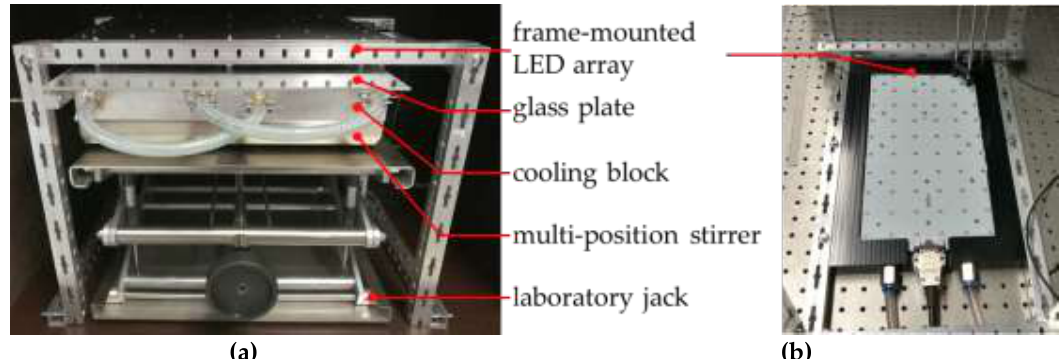
Figure 6. Applied photocatalysis reactor system (thermostats, controllers, light-tight box not shown): ( a ) Front view; ( b ) Bottom view of the UV-A light emitting diode (LED) array showing the 60 LED arrangement.